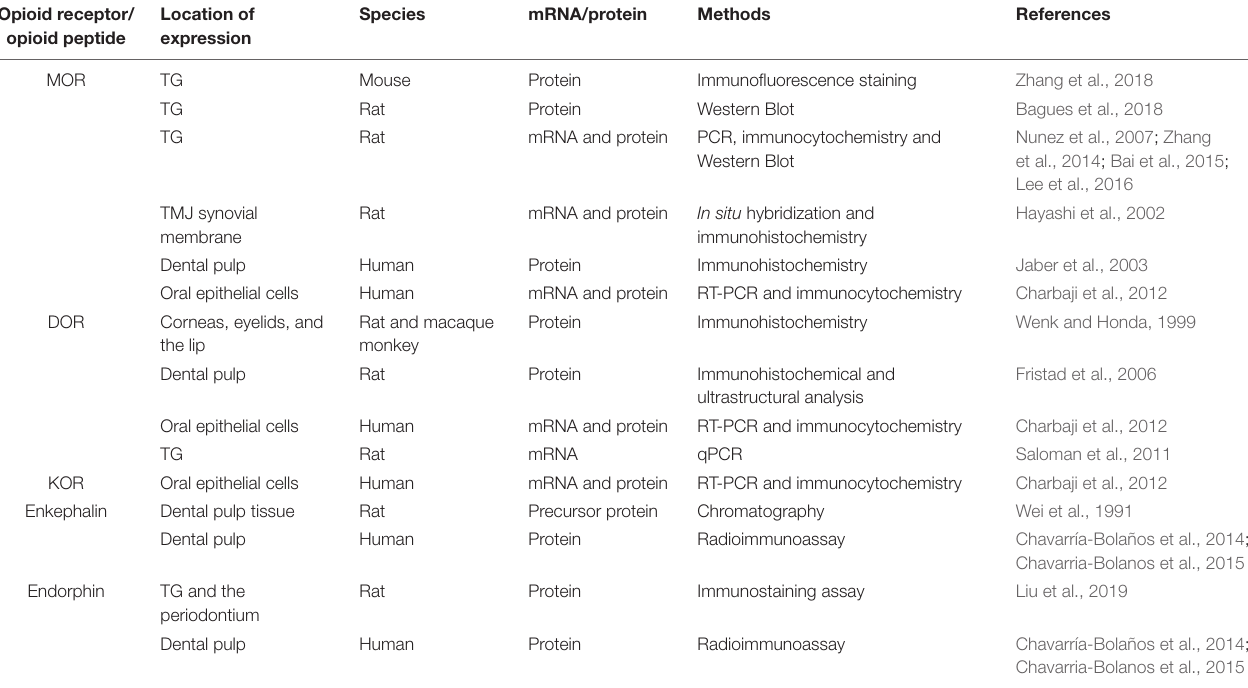
TABLE 2 | The expression of EOPs and PORs in orofacial tissues. Opioid receptor/ opioid peptide